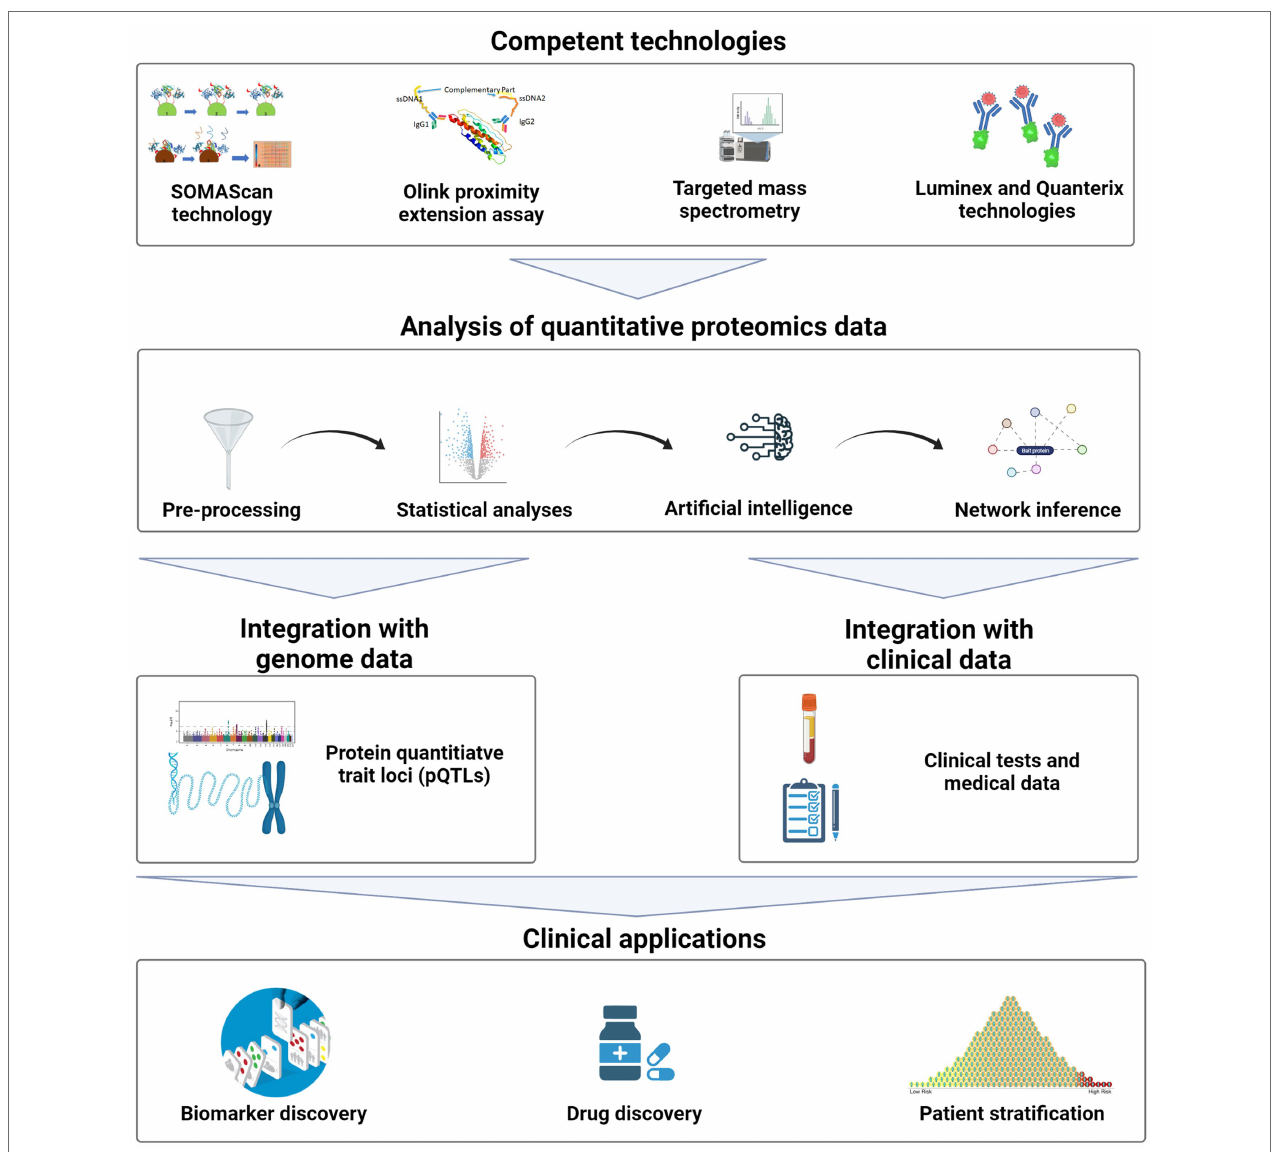
FIGURE 1 | General workflow for quantitative proteomics. The figure describes the different types of targeted technologies, and the common methodologies to analyse quantitative proteomics data. These analyses potentially provide clinical applications in biomarker and drug discovery and patient stratification. Image created with